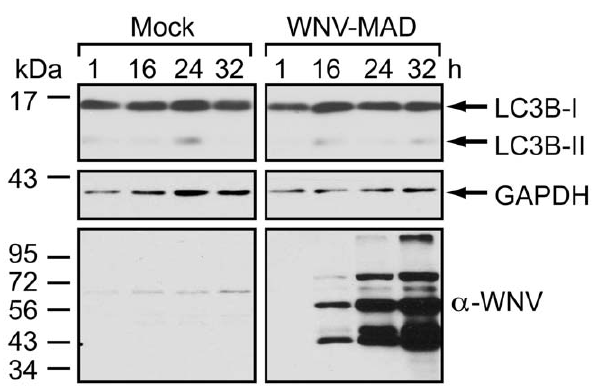
Figure 6. WNV-MAD78 infection does not induce autophagy. 293T monolayers were mock-infected or infected with WNV-MAD78 (MOI=3). Following infection, cells were grown in medium containing 10 m g/mL Pepstatin A and E64d. Whole cell lysates prepared at the indicated times (h) post-infection were subjected to immunoblot analysis for LC3B (top), GAPDH (middle) and WNV (bottom).